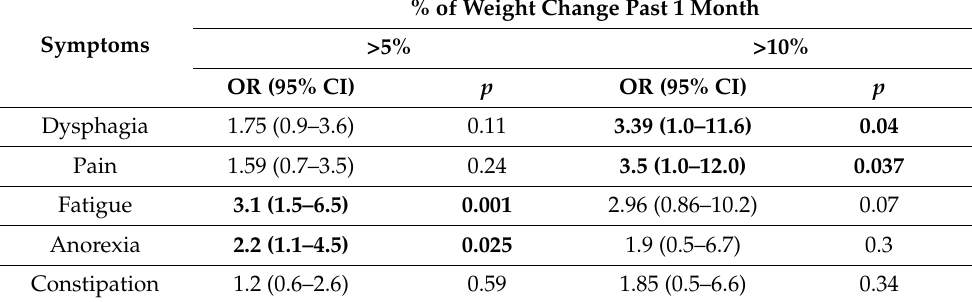
Table 3. The association between percentage of weight change in the past 1 month and digestive